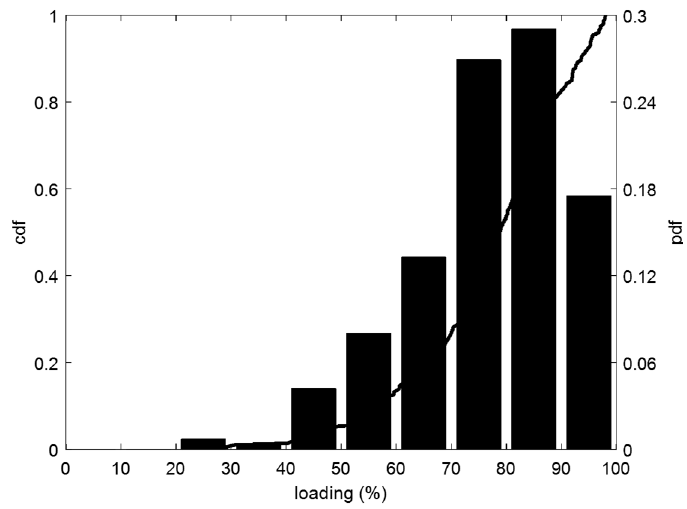
Figure 10. Evaluation of the lost potential with the distribution of the maximum loading for misclassified feeders (true class = U and predicted class = I).